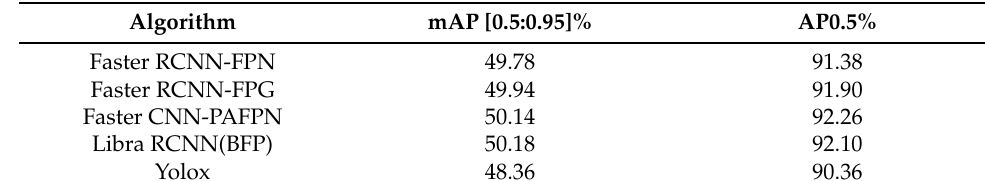
Table 4. Detection results of different algorithms.